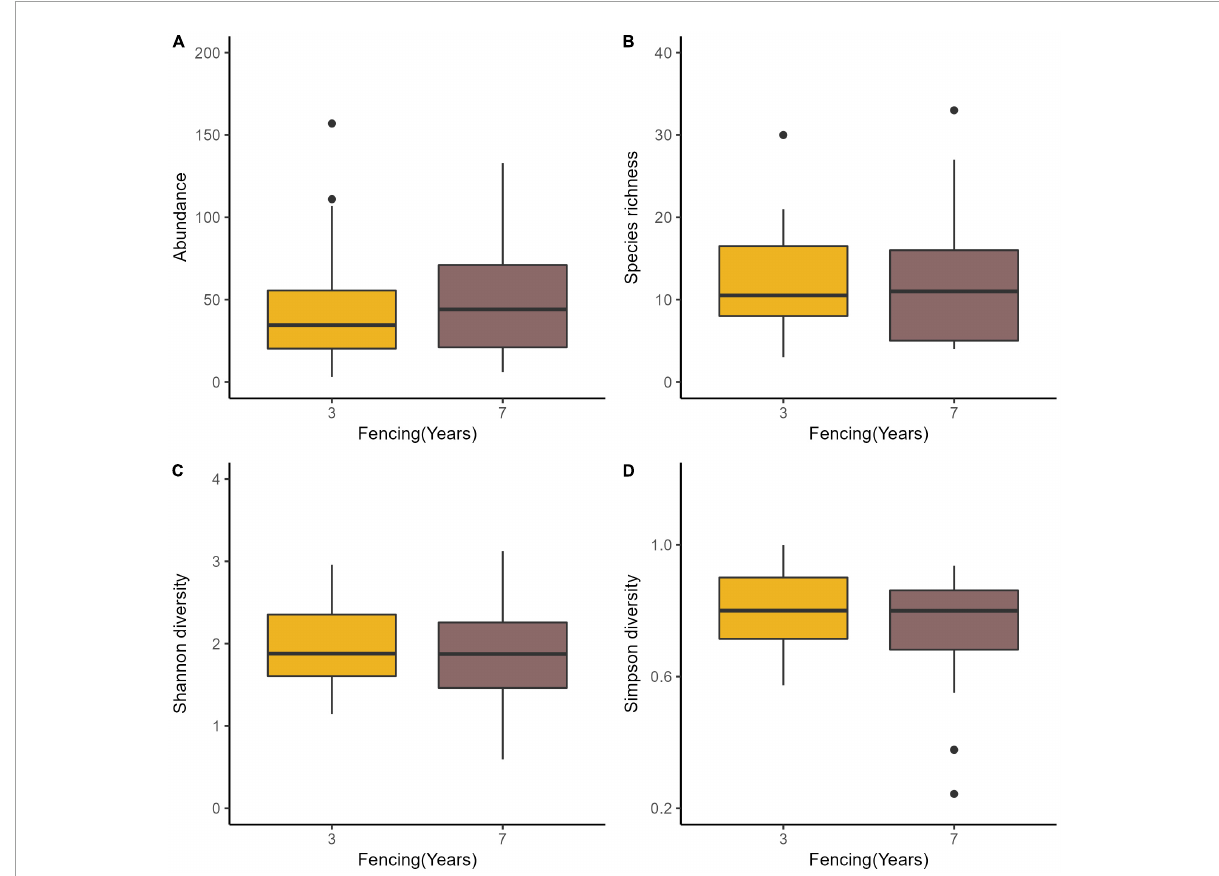
FIGURE4 Boxplots of insect species abundance (A) , richness (B) , Shannon diversity (C) , and Simpson diversity (D) in two fencing periods in a desert steppe: 3 fencing years and 7 fencing